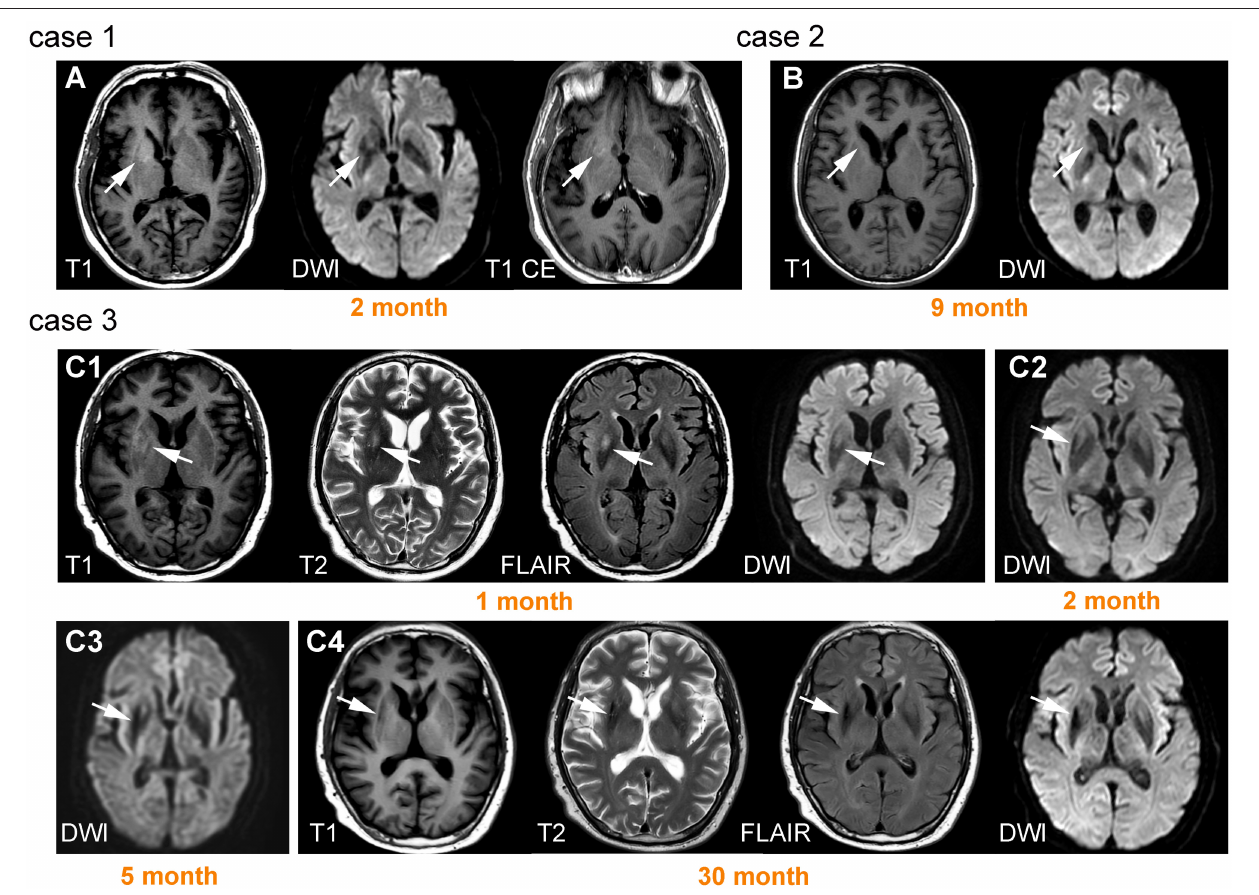
FIGURE 4 | Lesions on basal ganglia and their signal change over time. Case 1 was a 66-year-old male patient with left faciobrachial dystonic seizure (FBDS). A lesion was observed on the right basal ganglia (BG) with T1 hyperintensity and diffusion-weighted imaging (DWI) hypointensity, accompanied by ring-shaped enhancement (A) . Case 2 was a 57-year-old male patient with epileptic seizure. Brain MRI showed prominent right caudate nucleus atrophy and DWI hypointensity 9 months after onset (B) . Case 3 was a 61-year-old male patient presenting with left FBDS. Hyperintensity on T1, T2, fluid-attenuated inversion recovery (FLAIR), and DWI were initially observed on right BG (C1) . Hypointensity on DWI began to appear 2 months after onset (C2) and became more prominent accompanied by atrophy 3 months later (C3) . High signals were replaced by hypointensity 30 months after onset (C4)